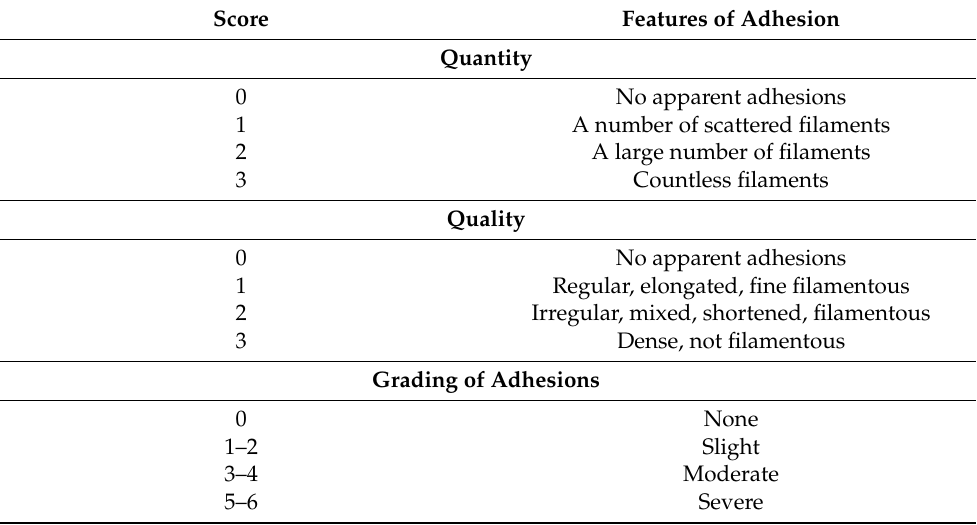
Table 1. Criteria for the histological evaluation of peritendinous